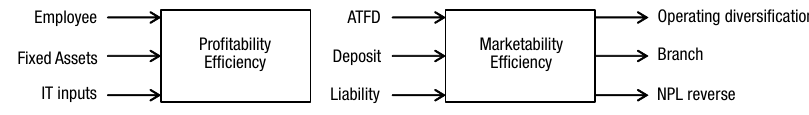
Fig. 1. The two-stage DEA